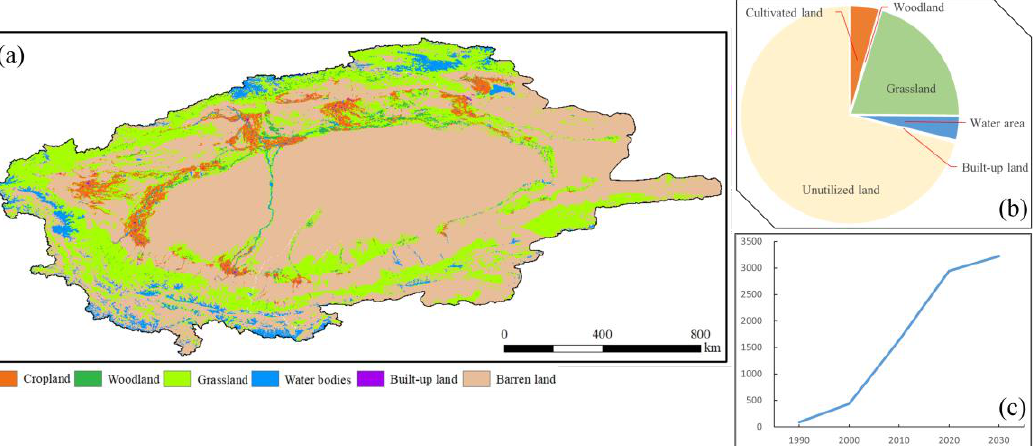
Figure 6. Land use changes in the Tarim River Basin in future periods. Figure ( a ) shows the land use changes in the watershed in 2030. Figure ( b ) shows the percentage of land types in the watershed in the future period. Figure ( c ) shows change in built-up land area during the period. Table 4. Land use dynamic attitude in the Tarim River Basin, 1990 – 2020 (%).